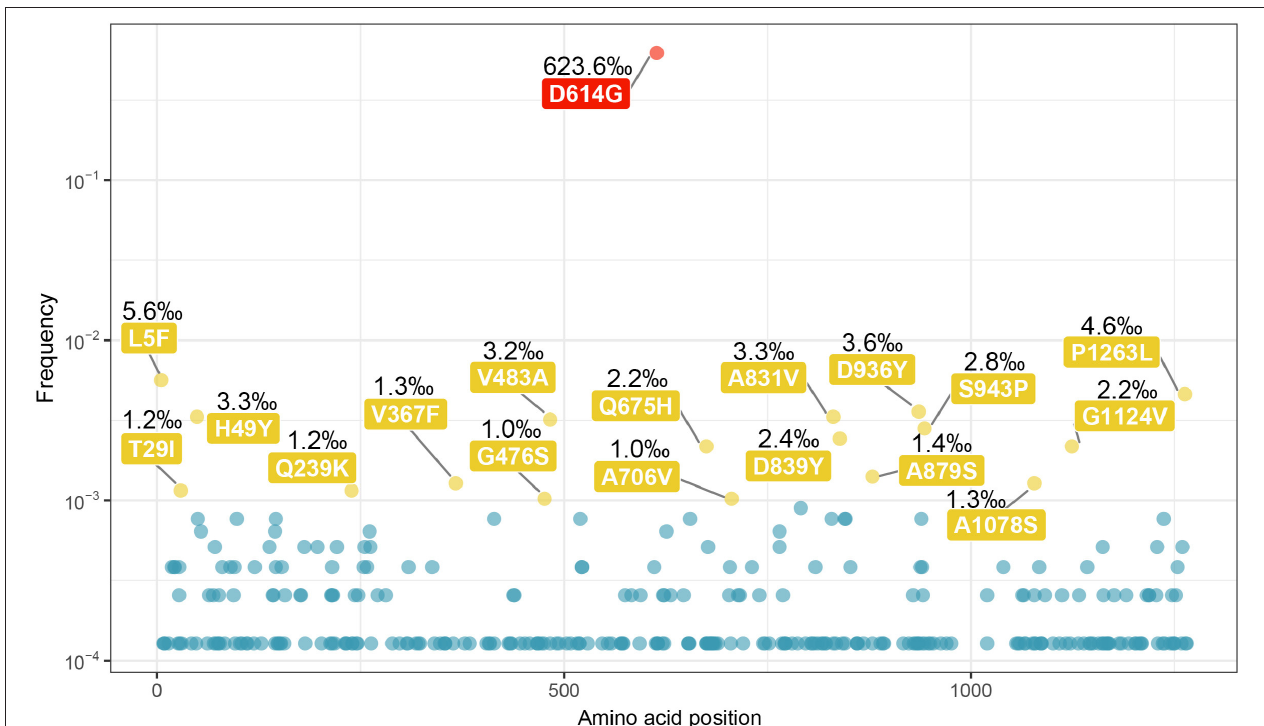
FIGURE 2 | Amino acid variations on the sequences of SARS-CoV-2 spike protein. All the amino acid variations on the sequences of SARS-CoV-2S protein were selected out, and the scatter plot was made according to the frequency of variation and the position on sequence. A total of 18 relatively high frequency sites were screened out (frequency > 10 − 3 ), including a highest frequency substitution site D614G. The sites with the highest frequency are indicated in red, and the rest of 17 were indicated in